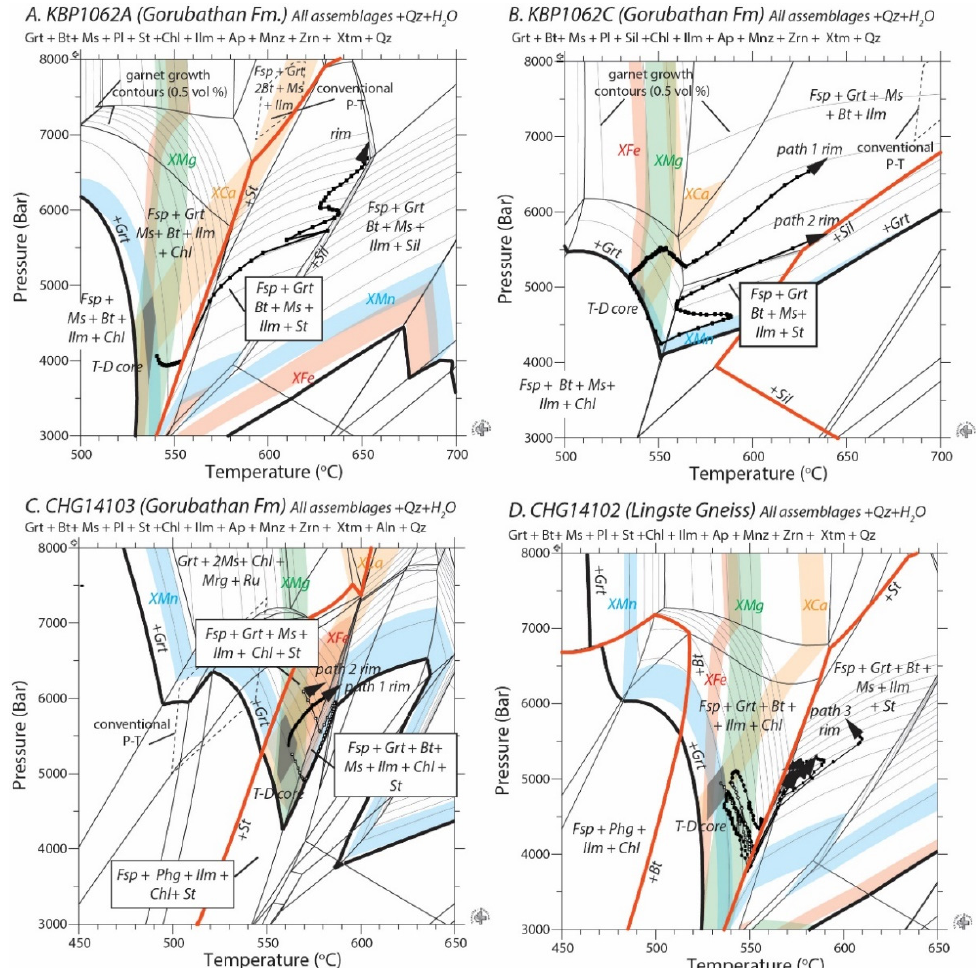
Figure 6. Isochemical phase diagrams and high-resolution P-T paths for samples ( A ) KBP1062A, ( B ) KBP1062C, ( C ) CHG14103, and ( D ) CHG14102. Mineral assemblages for the samples are listed under the sample names. In each diagram, the colored bars represent isopleths ±0.2 mole fraction of the garnet composition from the highest Mn portion of the garnet. Blue = spessartine content, green = pyrope, orange = grossular, and red = almandine. The intersection of the colored bars represents the garnet core conditions. Some mineral stability fields are labeled and indicate relevant reactions that mark the appearance of index minerals. Mineral abbreviations in this panel and elsewhere are after [97].